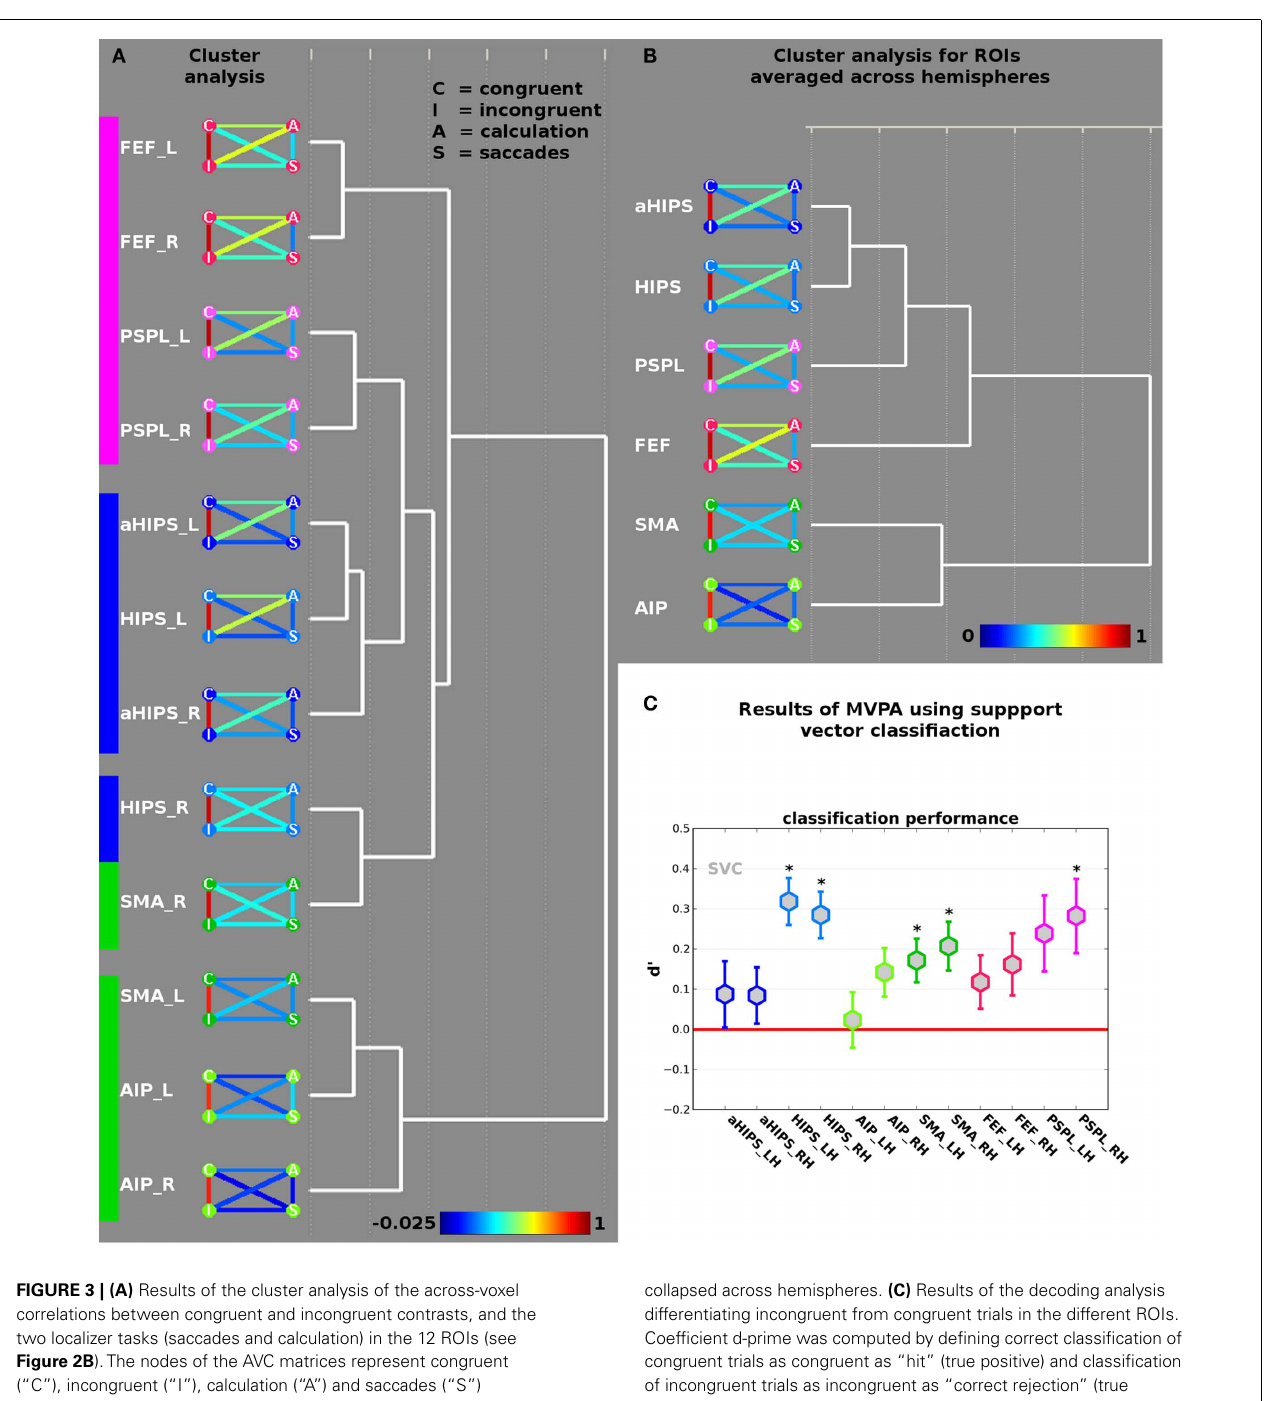
calculation. A third sub-cluster contains only two ROIs from the right hemisphere, i.e., HIPS_R and SMA_R. This sub-cluster might represent ROIs that link motor-related regions with number processing and